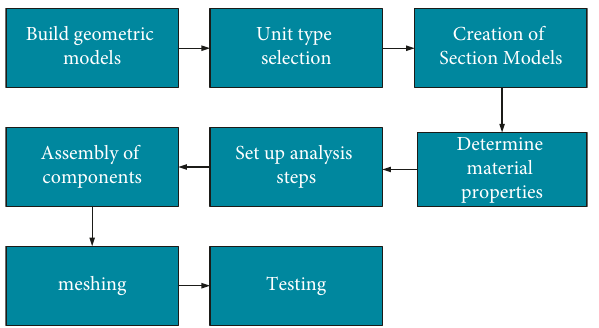
Figure 6: Overall construction process of finite element